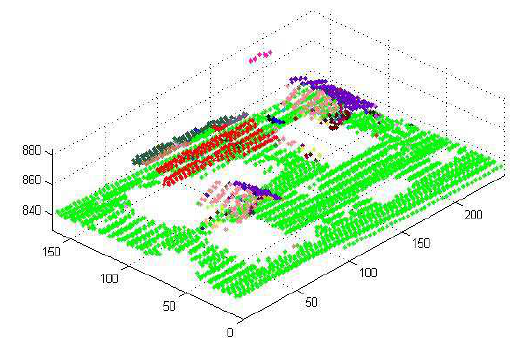
Figure 5. Color-coded point segments in part of the study